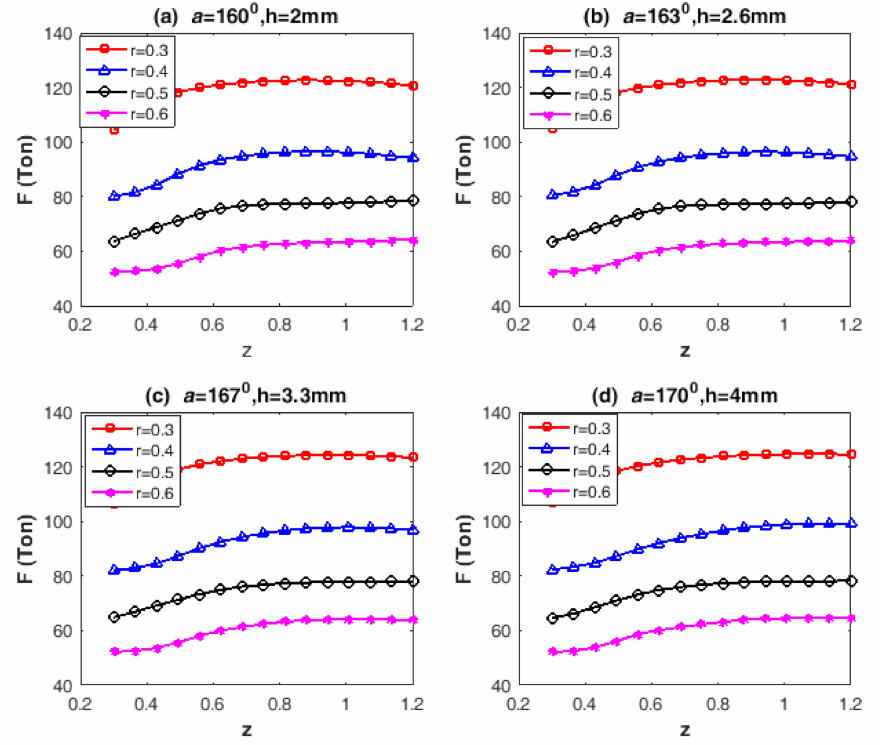
Figure 10. E ff ect of billet size ratio on the punch force with varying reduction ratios, punch angle ( a ), and land height (h) at ( a ) a = 160 ◦ , h = 2.0 mm; ( b ) a = 163 ◦ , h = 2.6 mm; ( c ) a = 167 ◦ , h = 3.3 mm; ( d ) a = 170 ◦ , h = 4.0